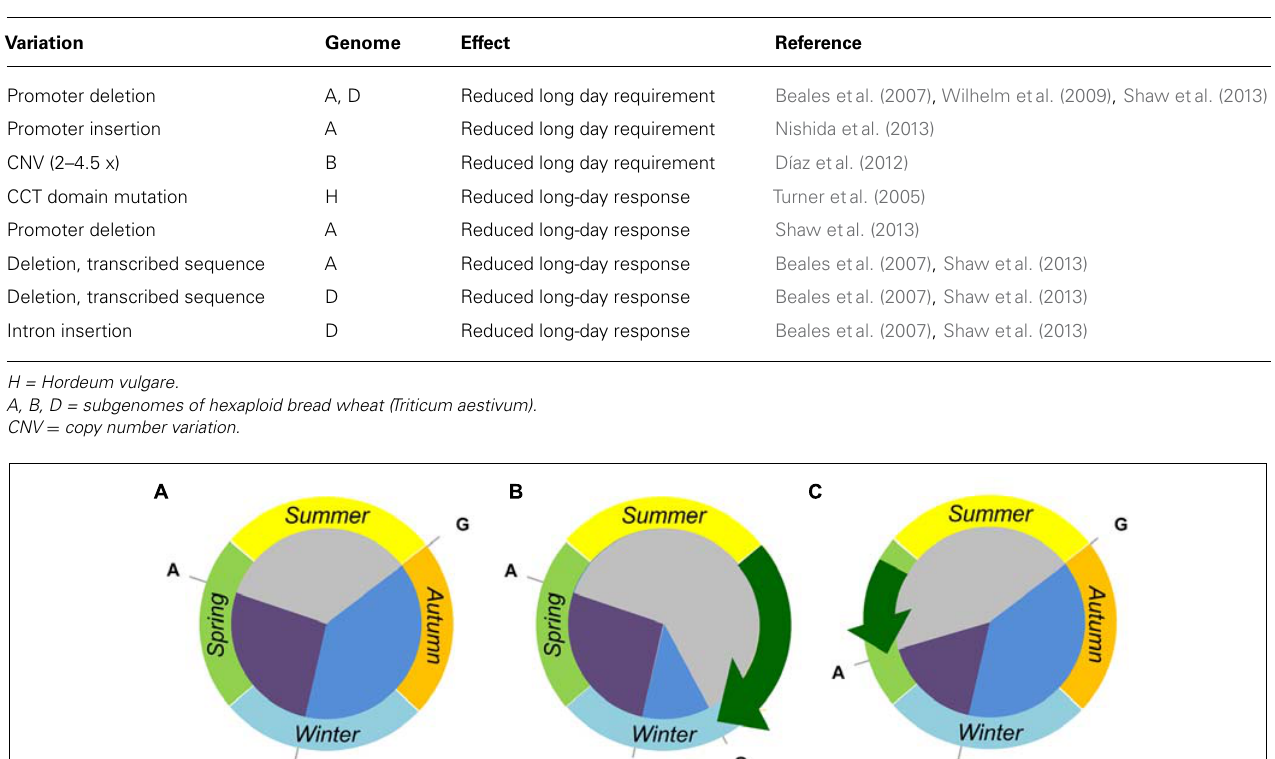
Table 2 |Variation in the PPD1 gene of cultivated cereals.